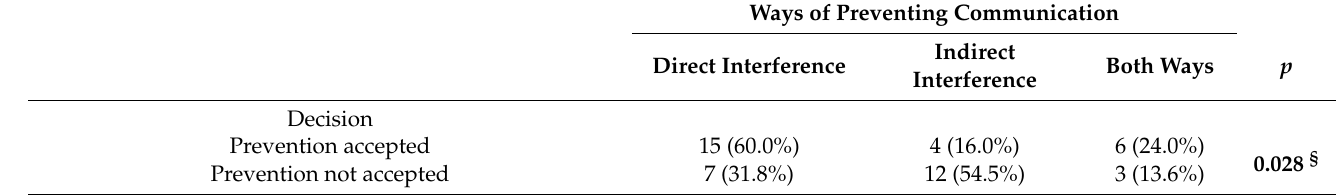
Ways of Preventing Communication Direct Interference